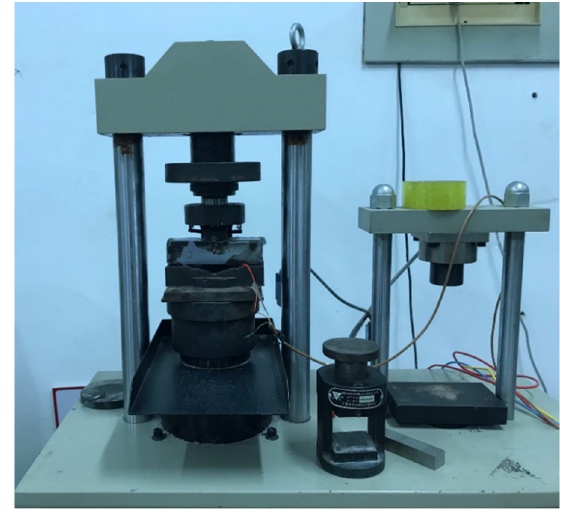
Figure 2. Bending test.